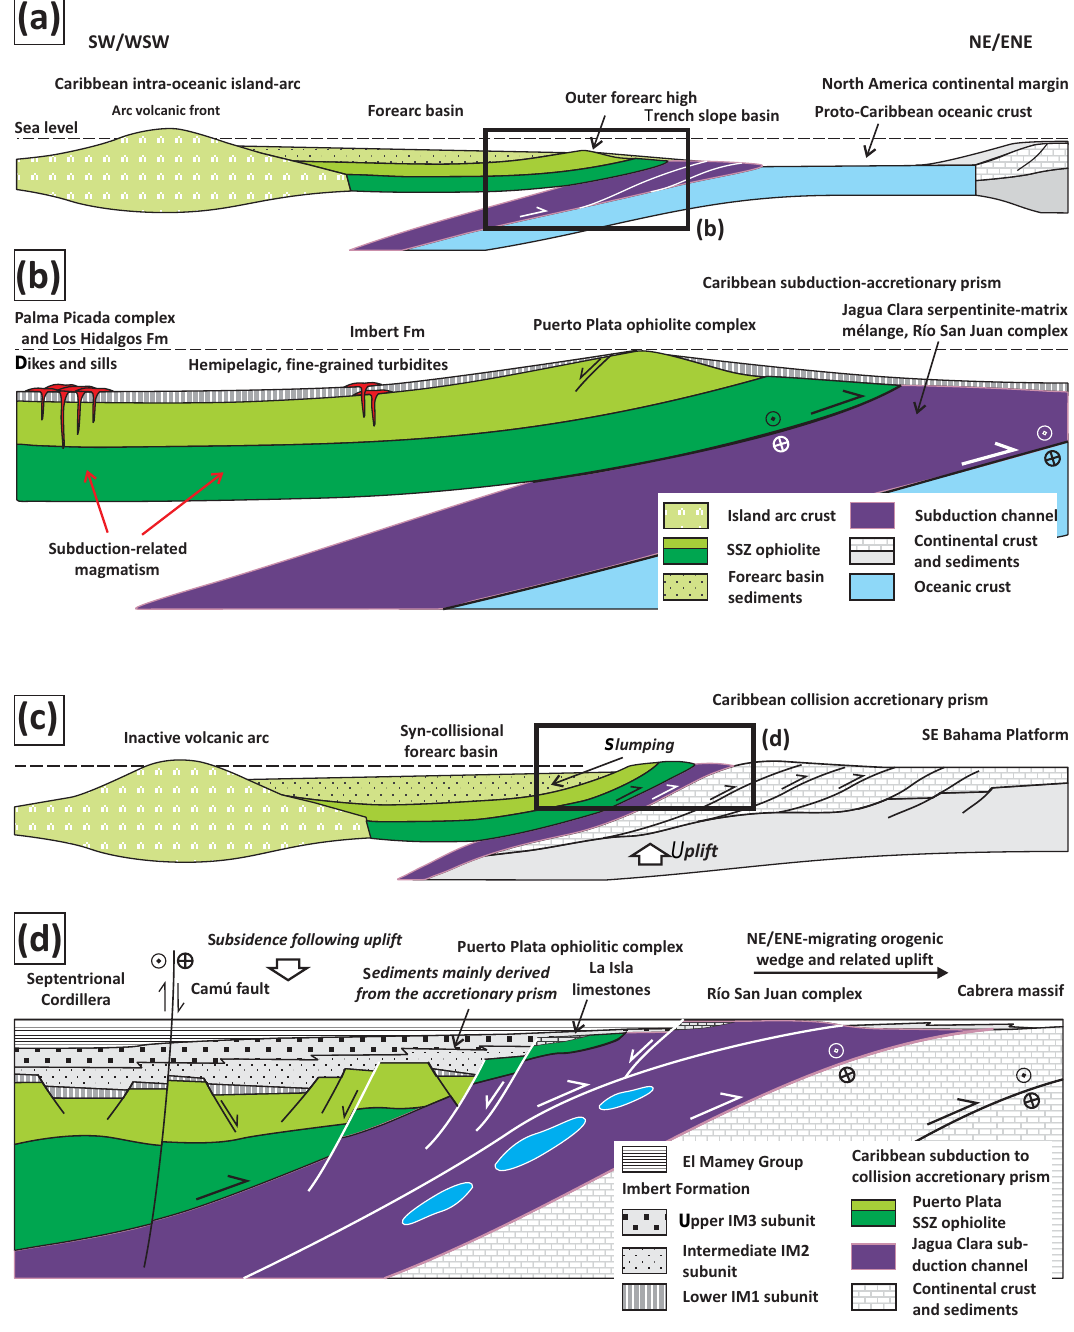
Figure 12. Schematic sedimentary and tectonic evolution of the Imbert Fm and the basal El Mamey Group along the northeastern edge of the pre-collisional forearc (a, b) and the syn-collisional basin (c, d) of the northern Caribbean subduction-accretionary prism.